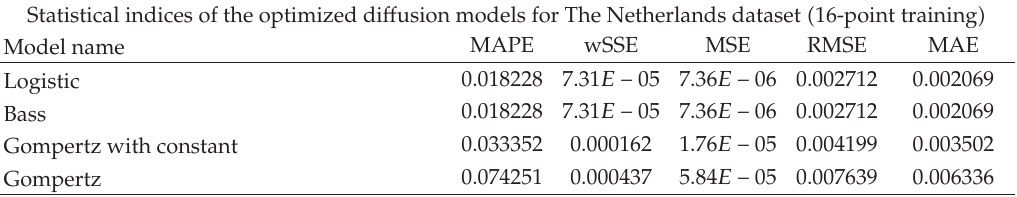
Table 18: Statistics for the optimized di ff usion models sorted by wSSE for The Netherlands (cid:2) forecast period—2 years (cid:3)